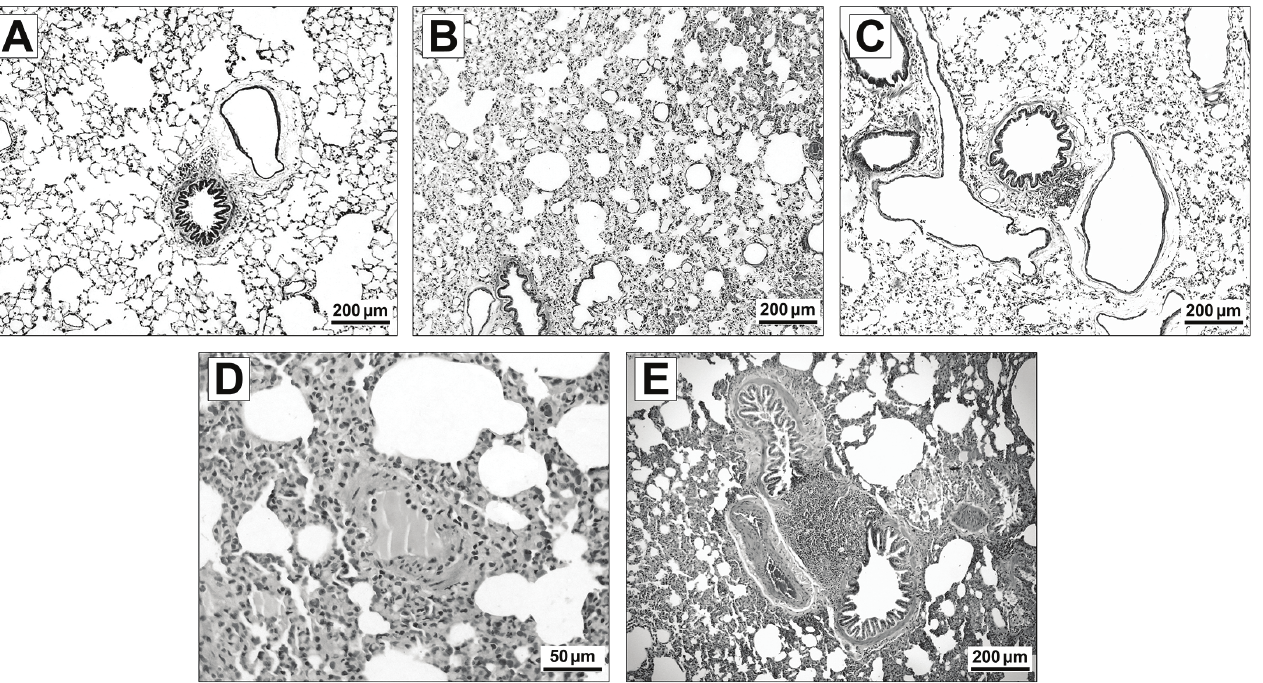
FIGURE 5 - Histology of lung tissue stained by hematoxylin and eosin (HE). Control group (A), Diabetes Mellitus group (B, D, E) and Diabetic Cissampelos sympodialis treatment group (C). Magnification 100X (A, B, C, E) and 400 X